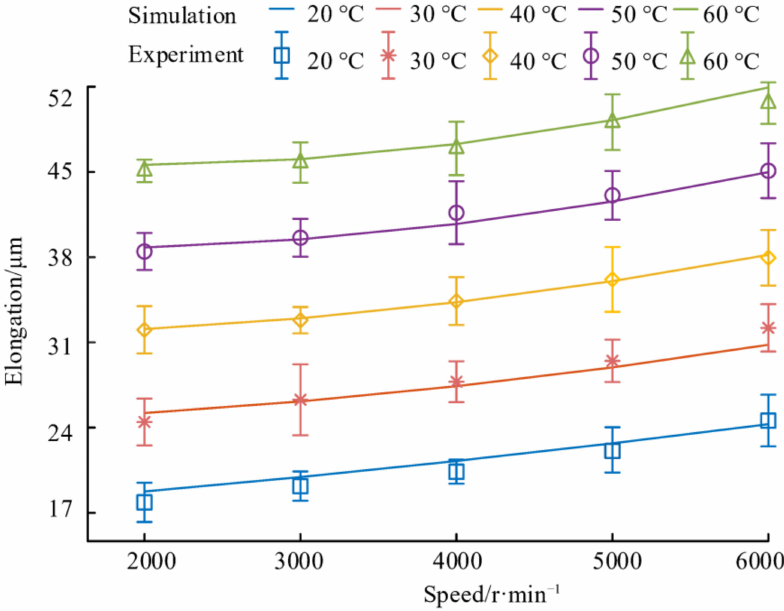
Figure 15. Effect of speed and temperature on the elongation of the NPR spacer. The effect of speed and temperature on the output force of the NPR spacer is shown in Figure 16. It can be found that the maximum standard deviation of all experimental results is 58 N. The maximum deviation between the experimental results and the average of the simulated results of the spacer output force at each temperature is 76 N. It shows that the simulation results match with the experimental results and proves the accuracy of the spacer thermo-mechanical coupling model. The NPR spacer axial output force increases as the temperature increases when the speed is constant and the NPR spacer output force increases as the speed increases when the temperature is constant. The NPR spacer output force, when the speed is increased from 2000 r/min to 6000 r/min at a specific temperature, is smaller than when this temperature is increased by 10 ◦ C at 2000 r/min. For example, when the speed is 2000 r/min and the temperature is increased from 20 ◦ C to 30 ◦ C, the NPR spacer output force increases by 465 N. In comparison, when the temperature is 20 ◦ C and the speed is increased from 2000 r/min to 6000 r/min, the NPR spacer axial elongation increases by 324 N. Temperature has a greater effect on the output force of the NPR spacer than speed. This is because when the temperature of the spacer is increased by 10 ◦ C, the axial elongation of the spacer is greater than the axial elongation when the speed is increased by 1000 r/min and there is a positive correlation between the spacer output force and the axial displacement of the